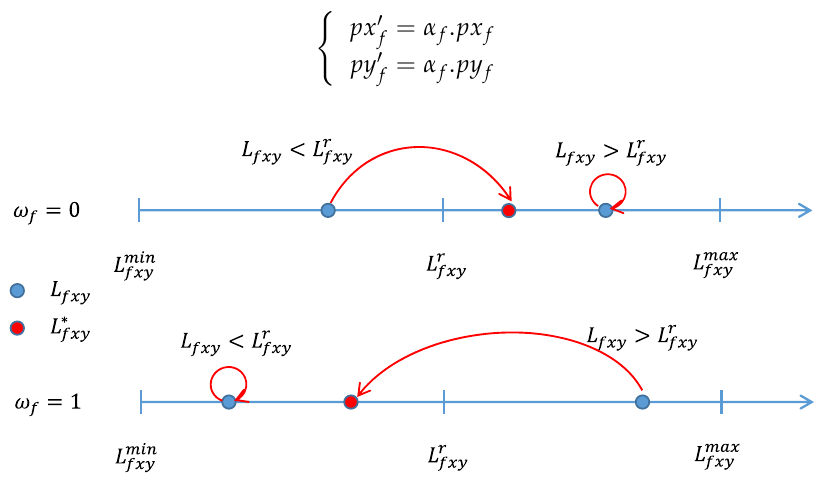
Figure 5. Watermark bit embedding by changing the vector length of a feature point.